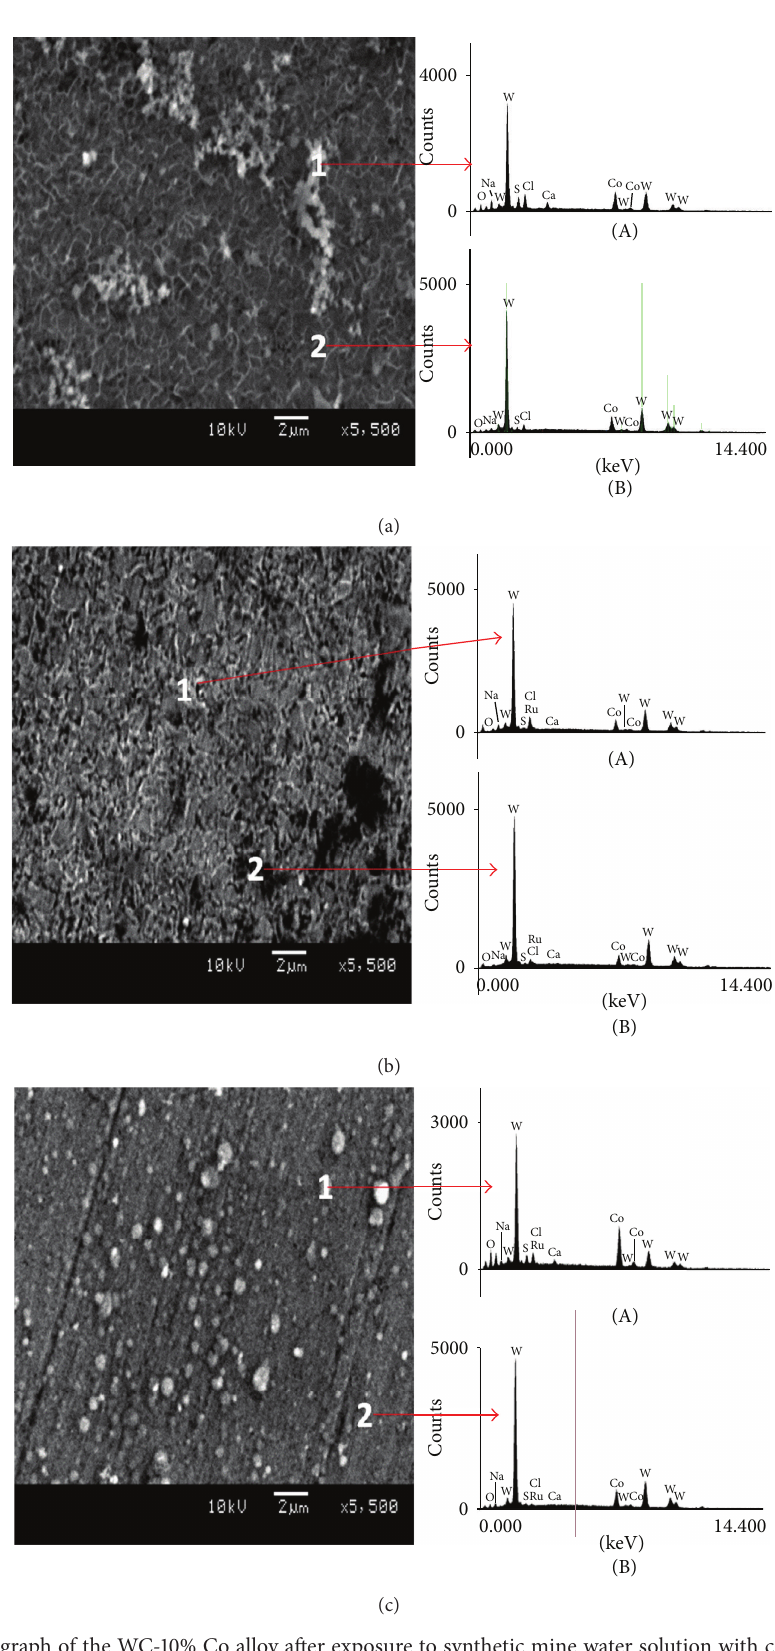
Figure 9: (a) SEM micrograph of the WC-10% Co alloy after exposure to synthetic mine water solution with corresponding EDX spectra analyses of (A) area 1 and (B) area 2. (b) SEM micrograph of the 3.0 wt% Ru containing alloy after exposure to synthetic mine water solution with corresponding EDX spectra analyses of (A) area 1 and (B) area 2. (c) SEM micrograph of the 0.4 wt% VC containing alloy after exposure to synthetic mine water solution with corresponding EDX spectra analyses of (A) area 1 and (B) area